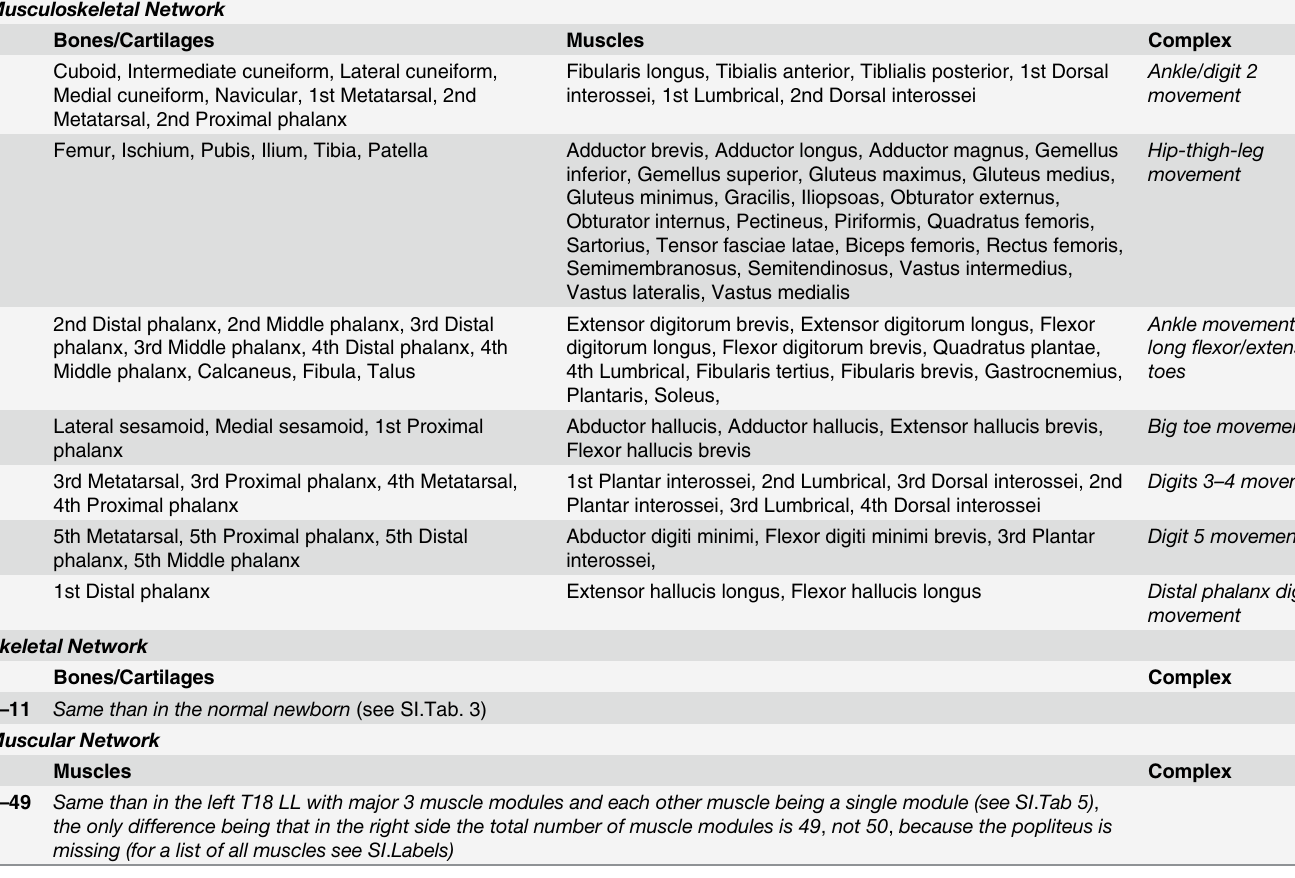
Table 7. Phenotypic modules in the right lower limb of the T18